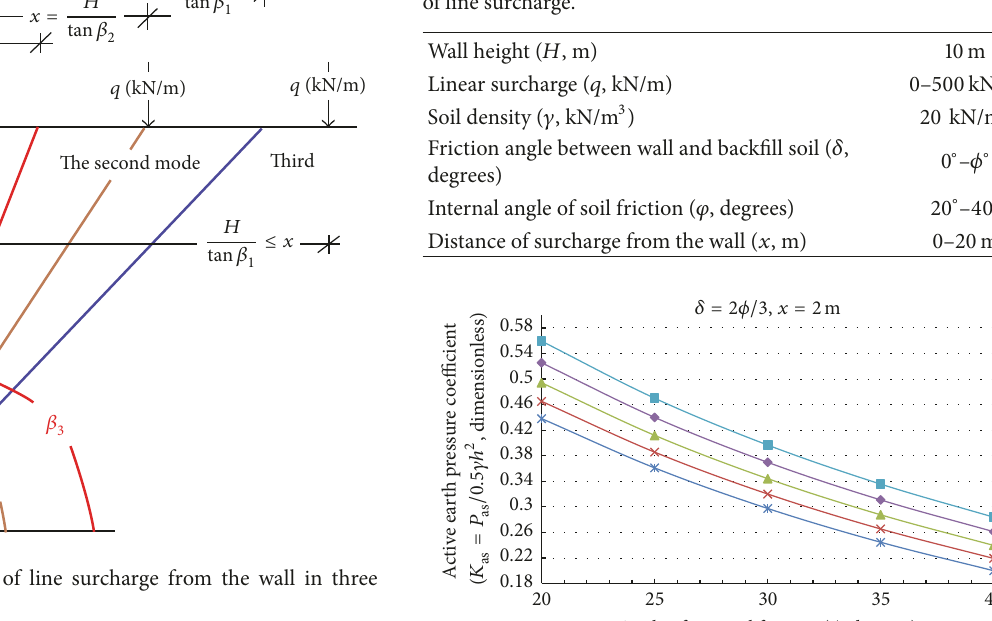
Figure 3: Changes in active pressure coefficient ( 𝐾 changes in the angle of internal soil friction for different amounts of line